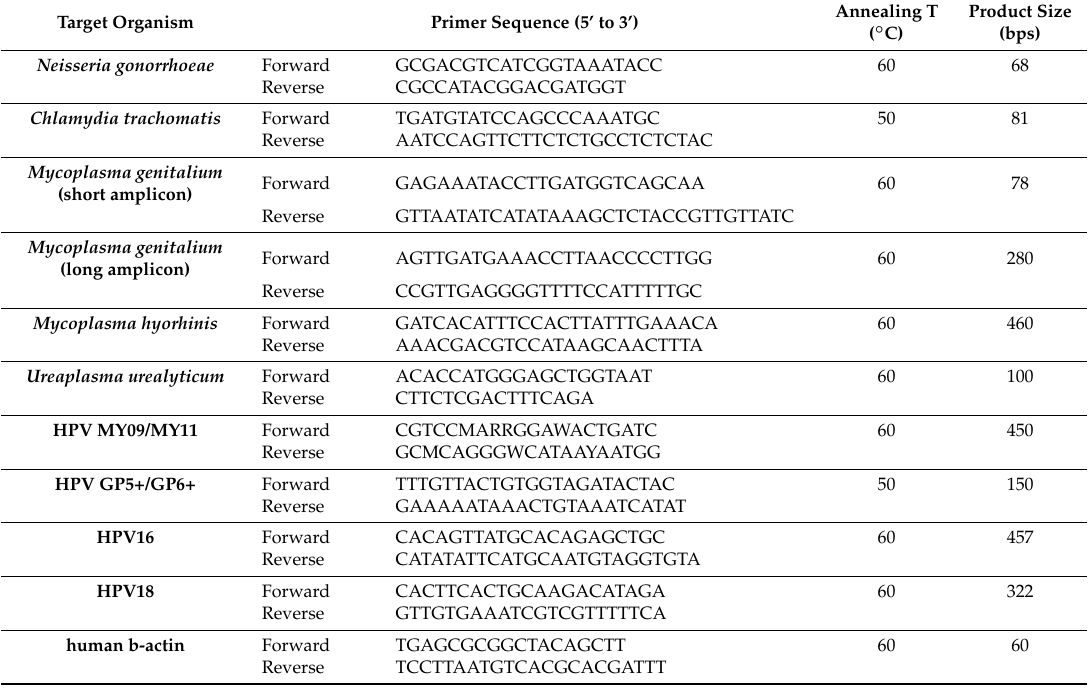
Table 1. Primers used in this study for detection of infection agents in prostate